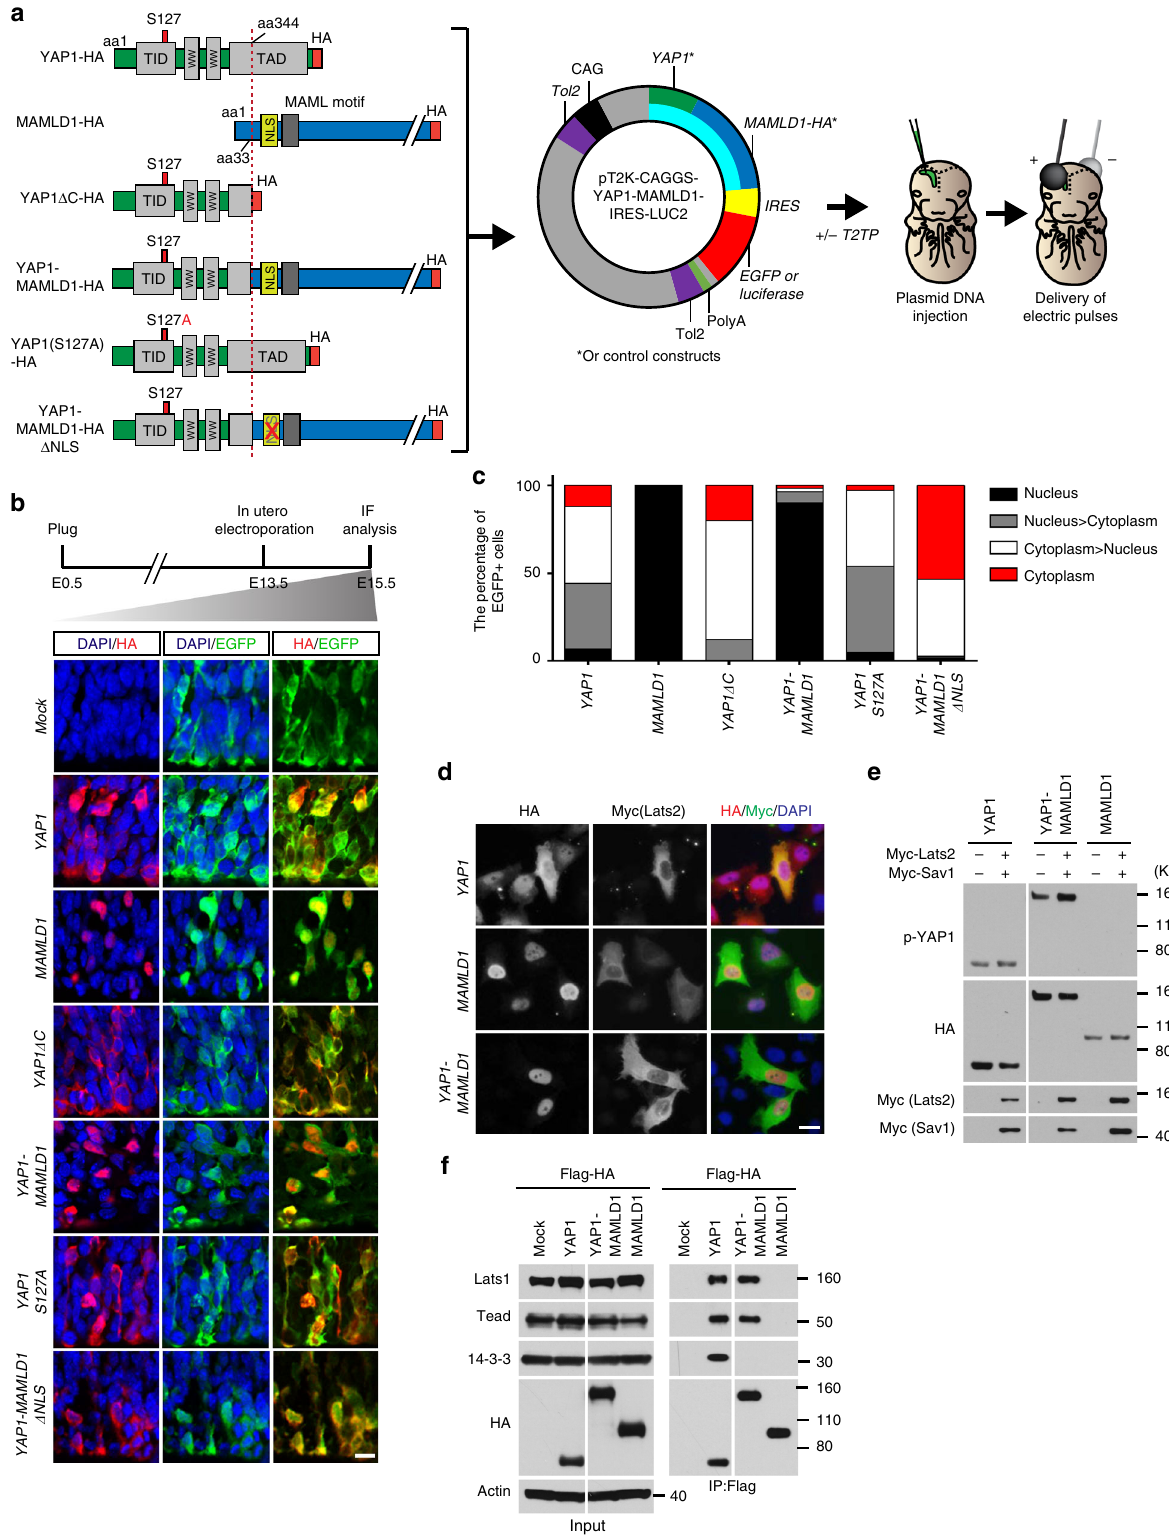
localized in the cytoplasm, exogenous wild-type MAMLD1 pro- tein (MAMLD1-HA) accumulated in the nucleus, consistent with a previous report 25 . The exogenous full-length YAP1-MAMLD1 fusion localized within the nucleus, similar to human ST-EPN- YAP1 tumor cells. Truncated YAP1 protein (YAP1 Δ C-HA),